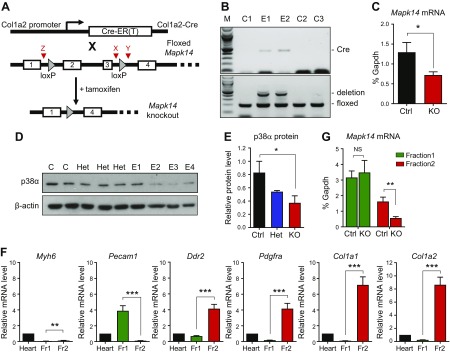
Inducible fibroblast-specific deletion of p38α in mouse heart. A) Schematic diagram of the deletion strategy, combining Col1a2-Cre-ER(T) mice with floxed Mapk14 mice. Deletion of exons 2–3 occurs after tamoxifen injection, which activates Cre-ER(T). Red arrowheads denote position of genotyping primers X, Y, and Z (see Materials and Methods). B) Genotyping PCR showing effective exon 2/3 deletion in ear notch samples from tamoxifen-injected, experimental Cre-positive Mapk14fl/fl mice (E1–2) compared with control Cre-negative Mapk14fl/fl mice (C1–3). Top: Cre primers (Cre = 408 bp). Bottom: Mapk14 exon 2/3 floxed/deletion primers. Deletion (Z + Y) = 411 bp; floxed (X + Y) = 188 bp; and M = 100-bp ladder. C) Real-time RT-PCR analysis of Mapk14 mRNA levels in primary cultures of cardiac fibroblasts from control (Ctrl) Cre-negative Mapk14fl/fl mice (n = 6) and Cre-positive Mapk14fl/fl KO mice (n = 8) after tamoxifen injection. *P < 0.05. D) Immunoblot analysis of p38α protein in primary cultures of cardiac fibroblasts from control Cre-positive Mapk14wt/wt (C), heterozygous Cre-positive Mapk14wt/fl (Het), and experimental Cre-positive Mapk14fl/fl mice (E1–4) after tamoxifen injection. β-actin loading control. E) Densitometric analysis of p38α protein expression relative to β-actin in control, heterozygous (Het), and experimental (KO) cells. *P < 0.05. F) Characterization of nonmyocyte, isolated cell fractions from collagenase-digested mouse hearts (n = 7). Fr1, endothelial cells and leukocytes; Fr2, cardiac fibroblasts. Bar charts show quantitative RT-PCR data for mRNA levels of cell type–specific marker genes. Cardiomyocyte marker, Myh6; endothelial marker, Pecam1; fibroblast markers, Ddr2, Pdgfra, Col1a1, and Col1a2. All data normalized to Gapdh mRNA levels and expressed relative to whole heart. **P < 0.01, ***P < 0.001. G) Real-time RT-PCR analysis of Mapk14 mRNA levels in isolated cell fractions from hearts of control Cre-negative Mapk14fl/fl mice (n = 3) and experimental Cre-positive Mapk14fl/fl KO mice (n = 4) after tamoxifen injection. NS, not significant. **P < 0.01.